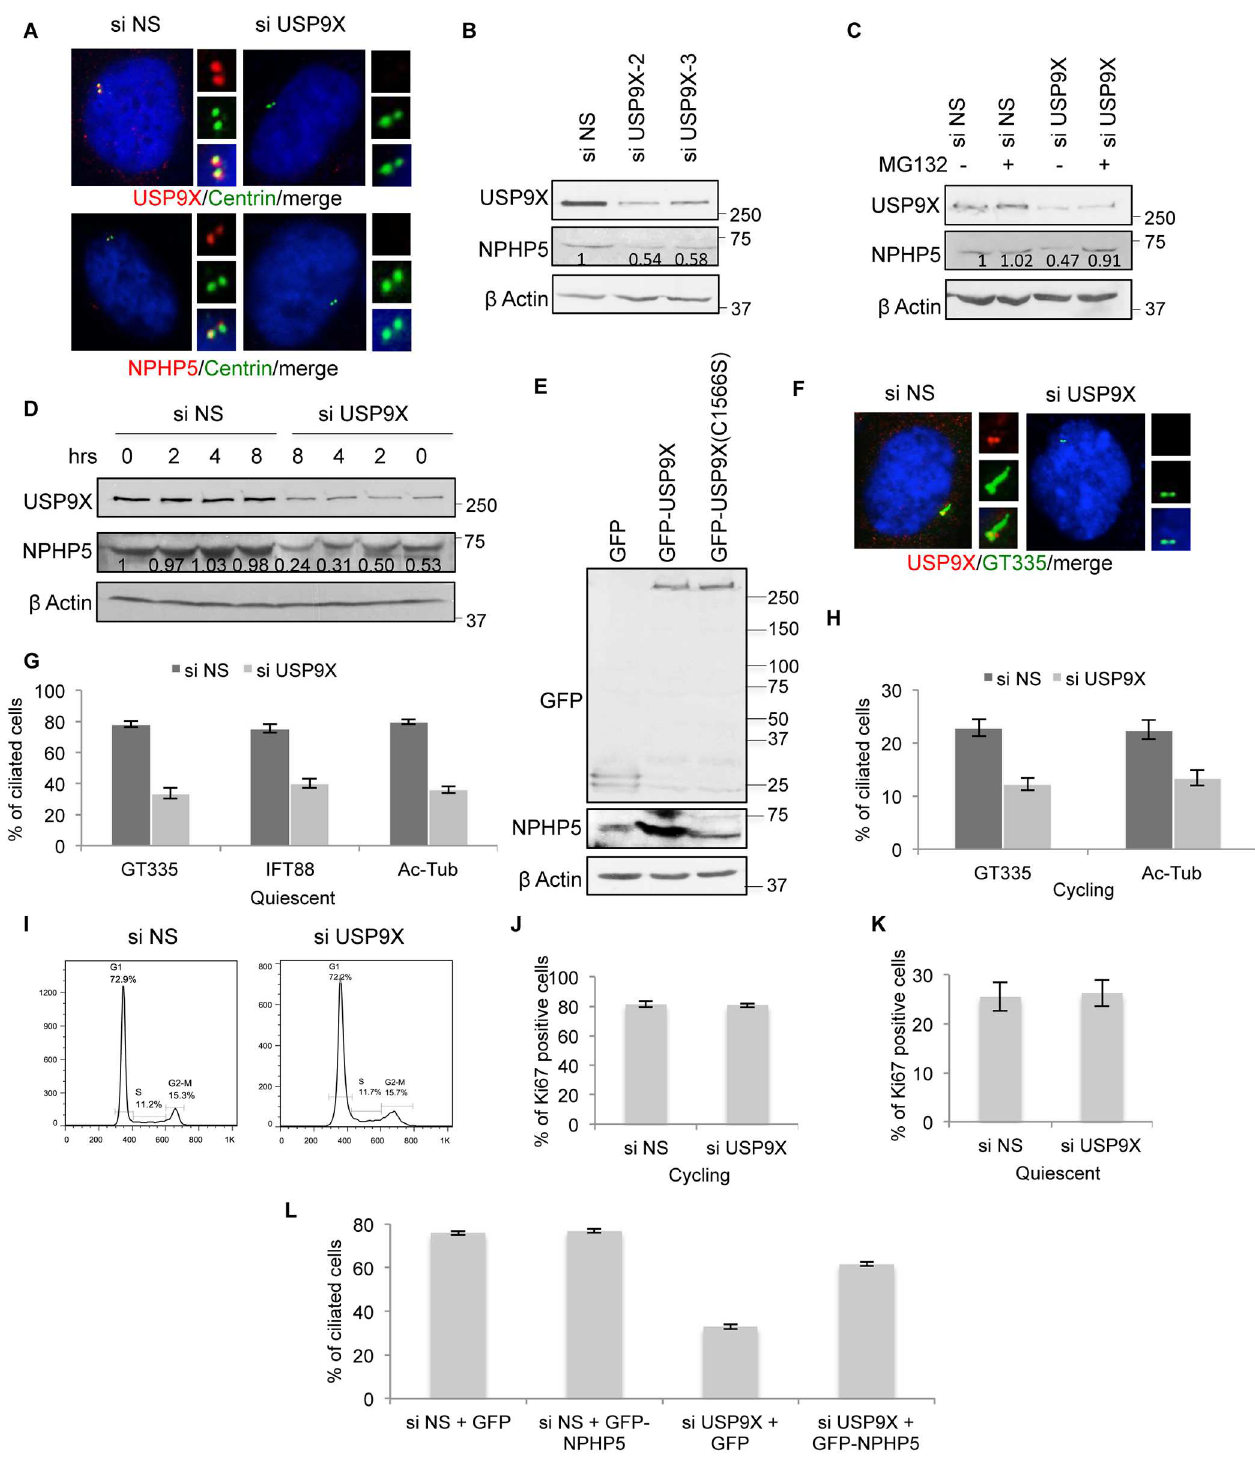
Fig 4. Effects of deregulating USP9X on NPHP5. A) RPE-1 cells transfected with control (NS) or USP9X siRNA and stainedwith antibodies against USP9X or NPHP5 (red) and centrin (green). DNA was stainedwith DAPI (blue). B) HEK293cells were transfected with control (NS) or USP9X siRNA. Lysates were Western blotted with the indicatedantibodies. β actin was used as a loadingcontrol. Numbers indicateNPHP5 protein levels relativeto control. C) HEK293 cells were transfected with control (NS) or USP9X siRNA and treated with or without MG132. Lysates were Western blotted with the indicatedantibodies. β actin was used as a loadingcontrol. Numbers indicate NPHP5 protein levels relative